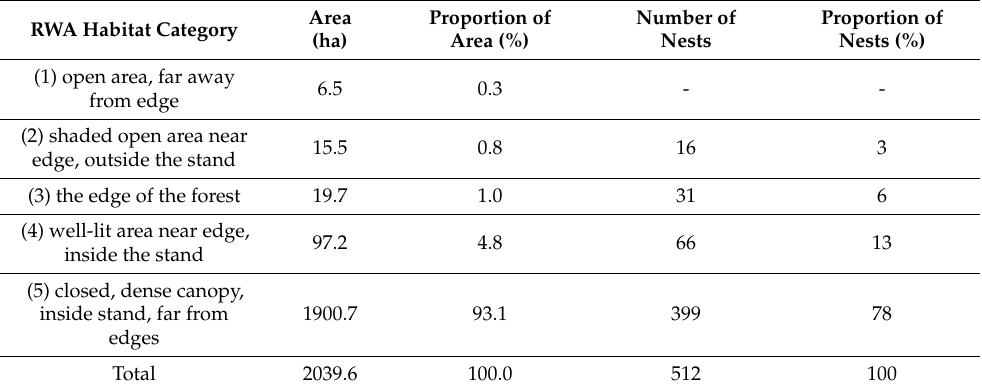
Table 1. Distribution of 2018 RWA according to canopy closure from the NDVI classification of RWA habitat categories.